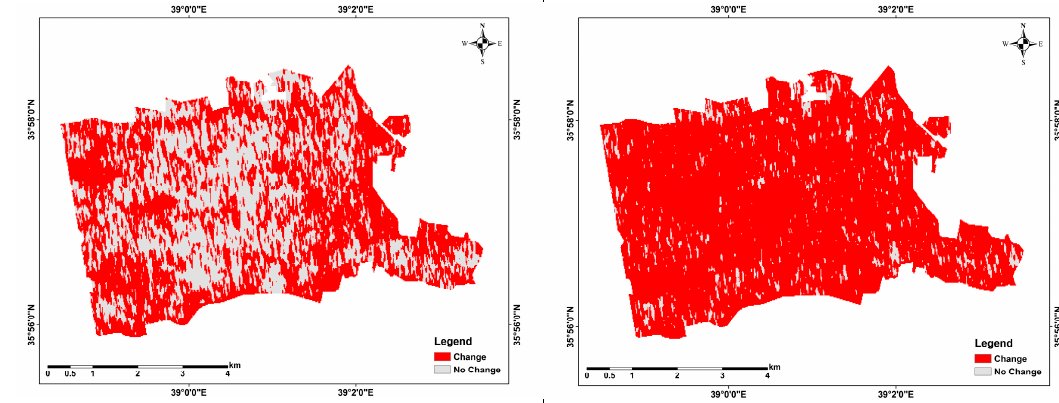
Figure 7. Raqqa Coherence image classified into change and no change showing coherence images of before (14 October 2016, left ) and after (27 September 2017, right ) the US-led forces operation against the Islamic State of Iraq and Syria (ISIS).